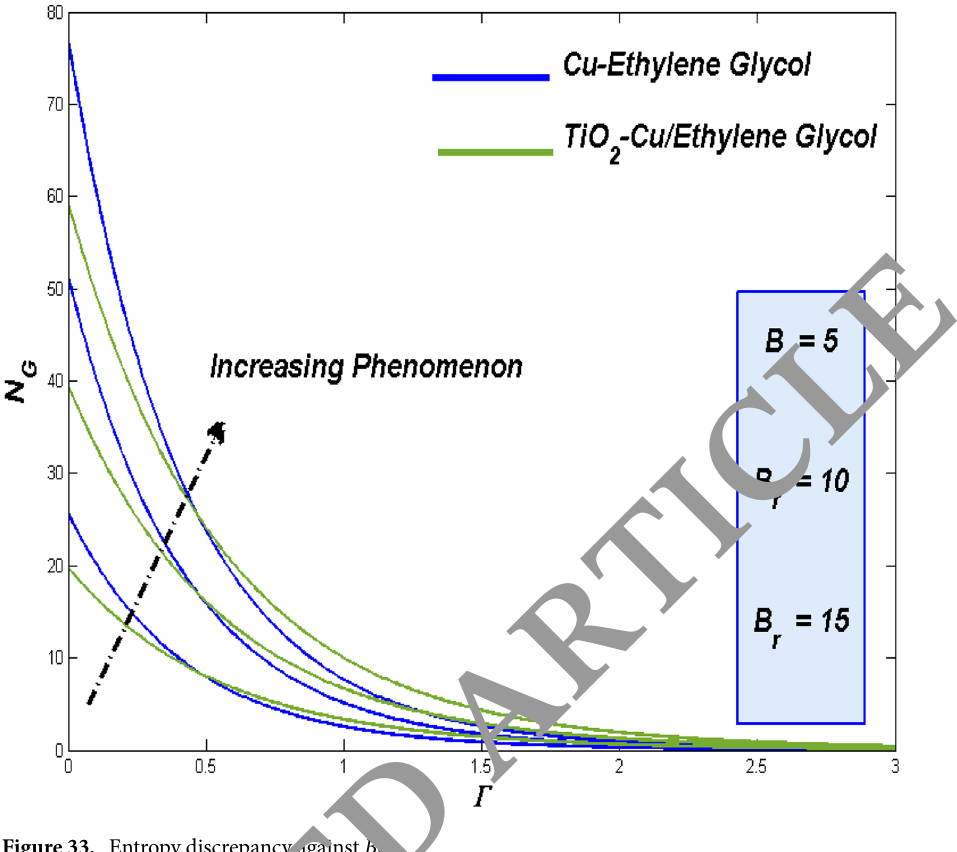
Figure 33. Entropy discrepancy against B r